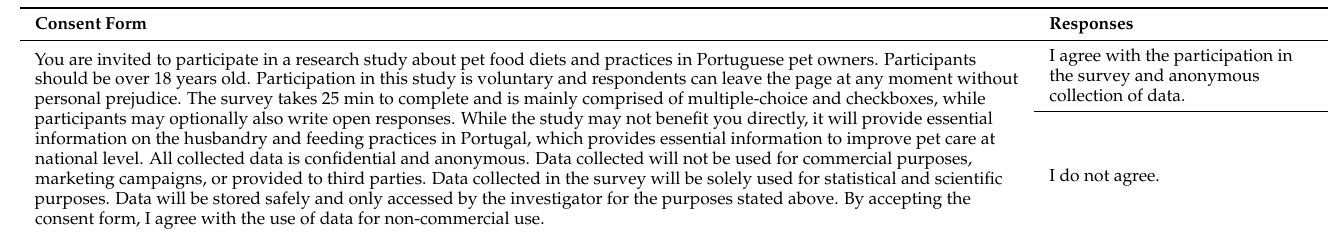
Table A2. Online informed consent form.